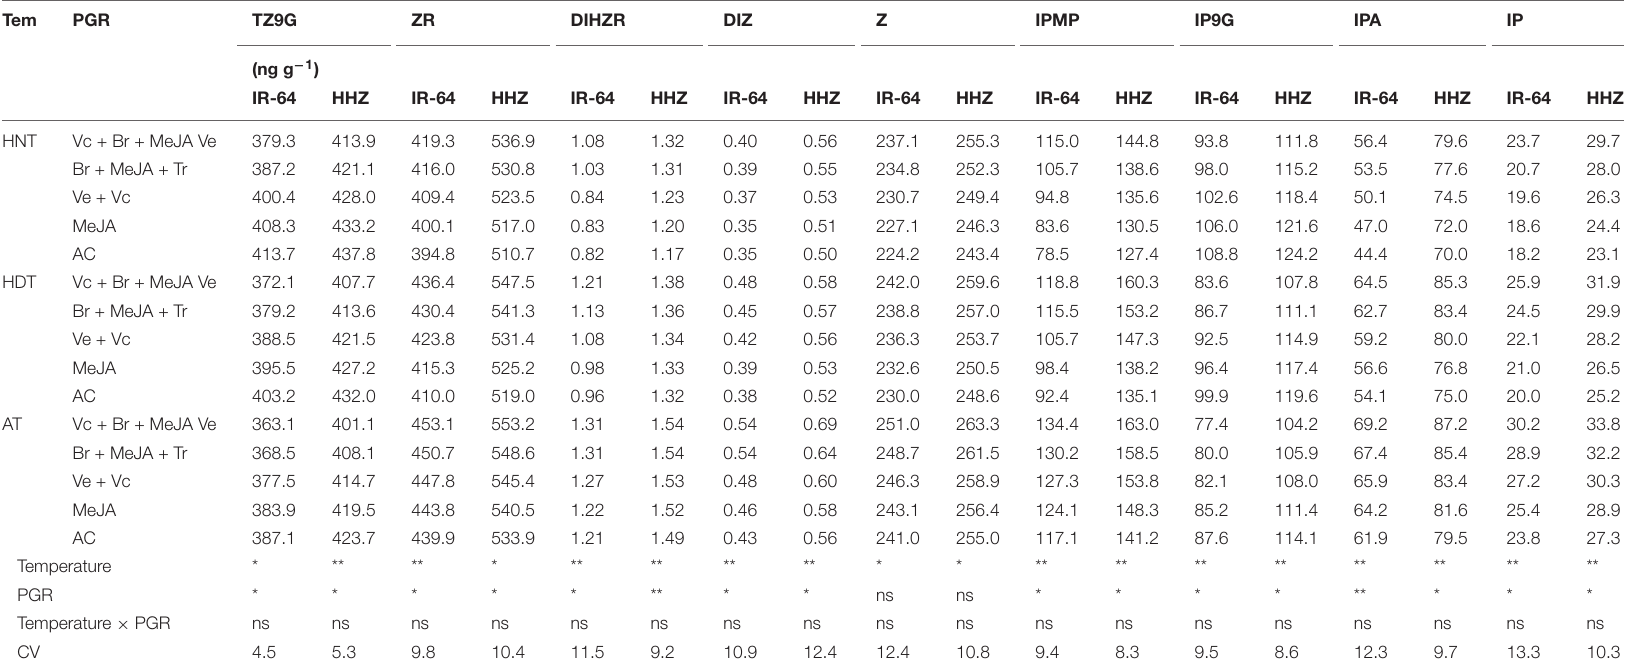
TABLE 3 | Impact of plant growth regulators on hormones content in rice leaves under heat stress at heading stage. Tem PGR